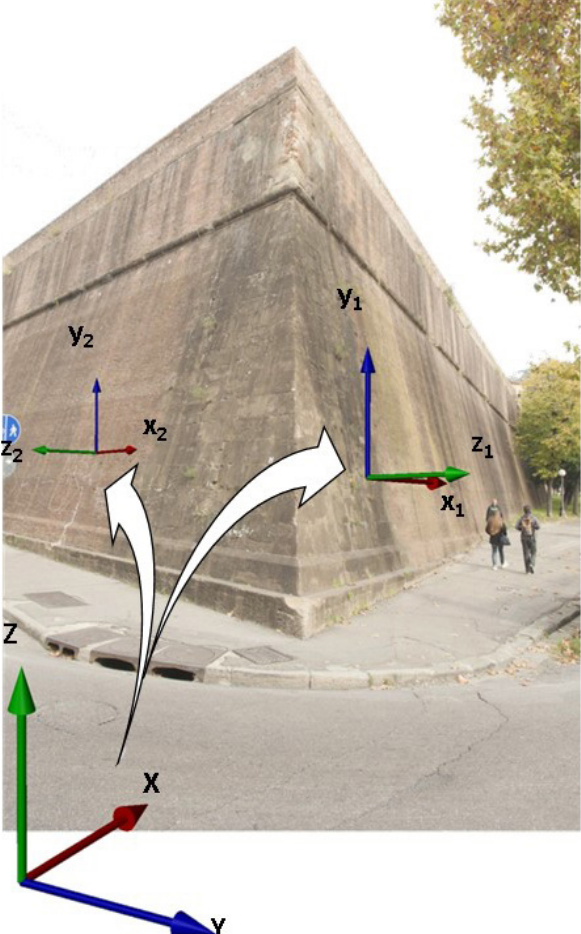
Figure 8. Different reference systems managed in the project: scan data are directly refered to the main r.s. (topographically defined by the control network) while photogrammetric GCP and CP need to be roto-tranlasated in local r.s.; the photogrammetric point model are then roto-tranlated back to merge all the data in the final 3D dababase